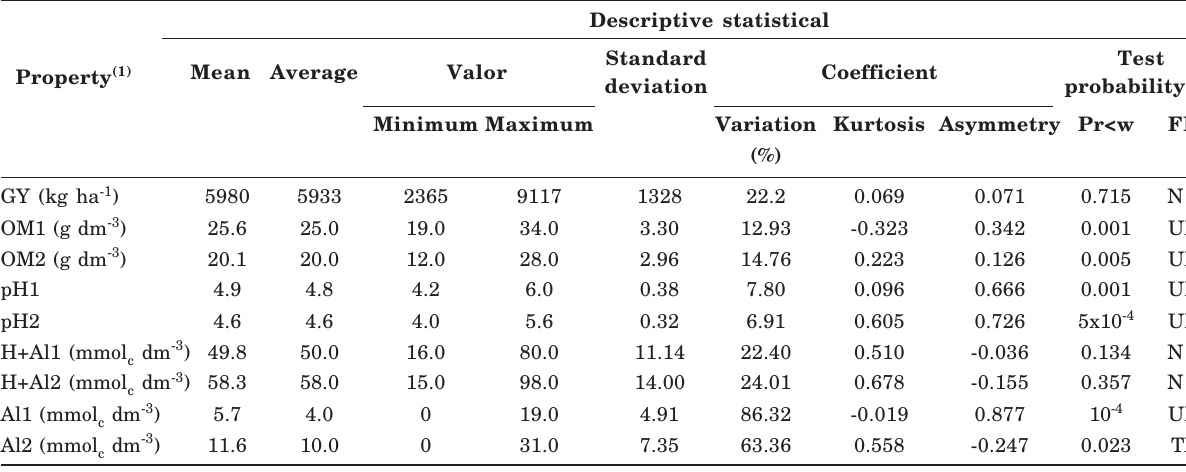
Table 3. Descriptive analysis of rice grain yield and some chemical properties of Typic Acrustox under no